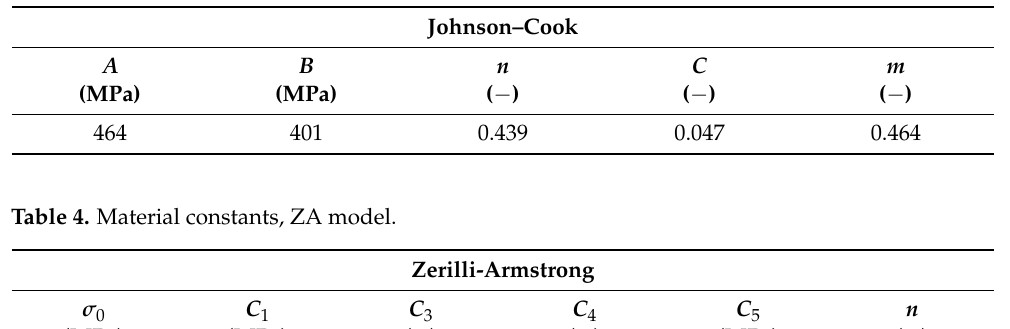
Table 3. Material constants, JC model.